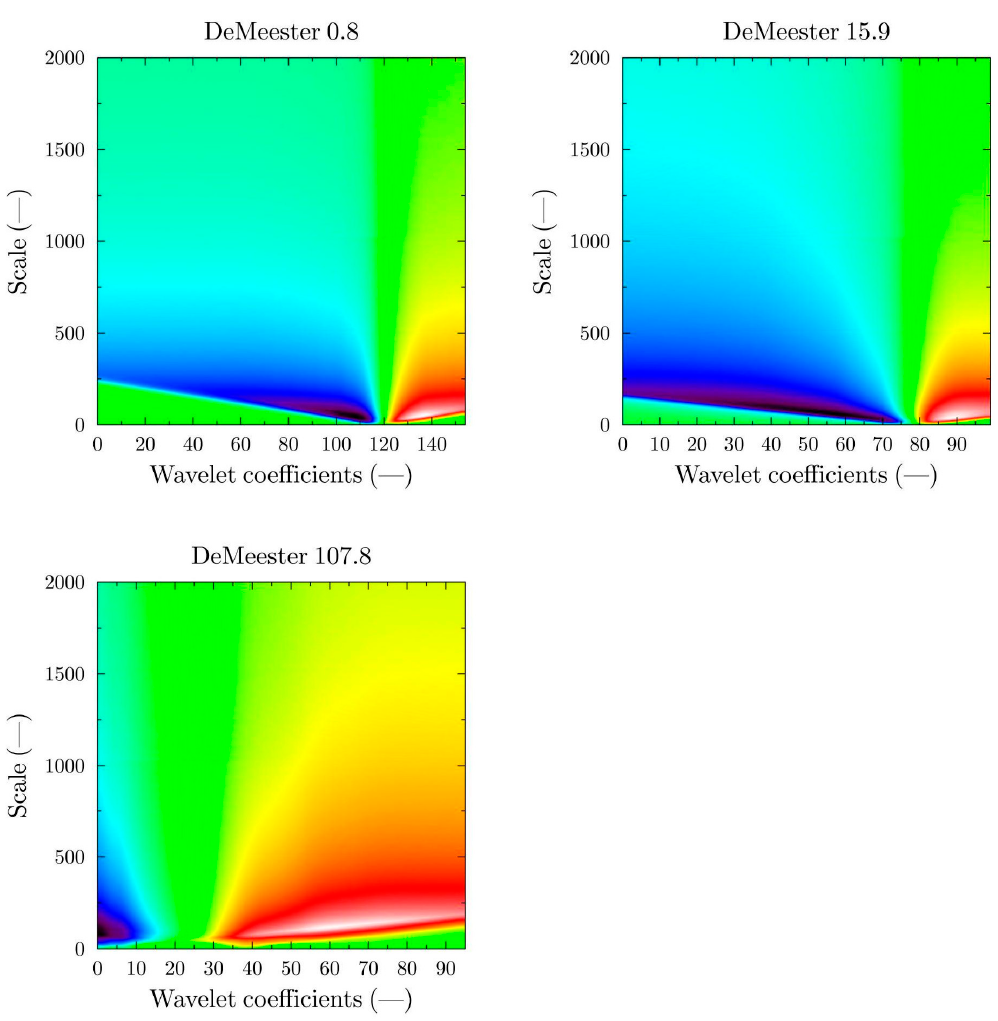
Figure 5. Scalograms of pH-metry signals obtained for Haar wavelet related to the 24-h measurement procedure. Scalograms show the result of the continuous wavelet transform, based on pH signals for the marginal cases of calculated DeMeester score.